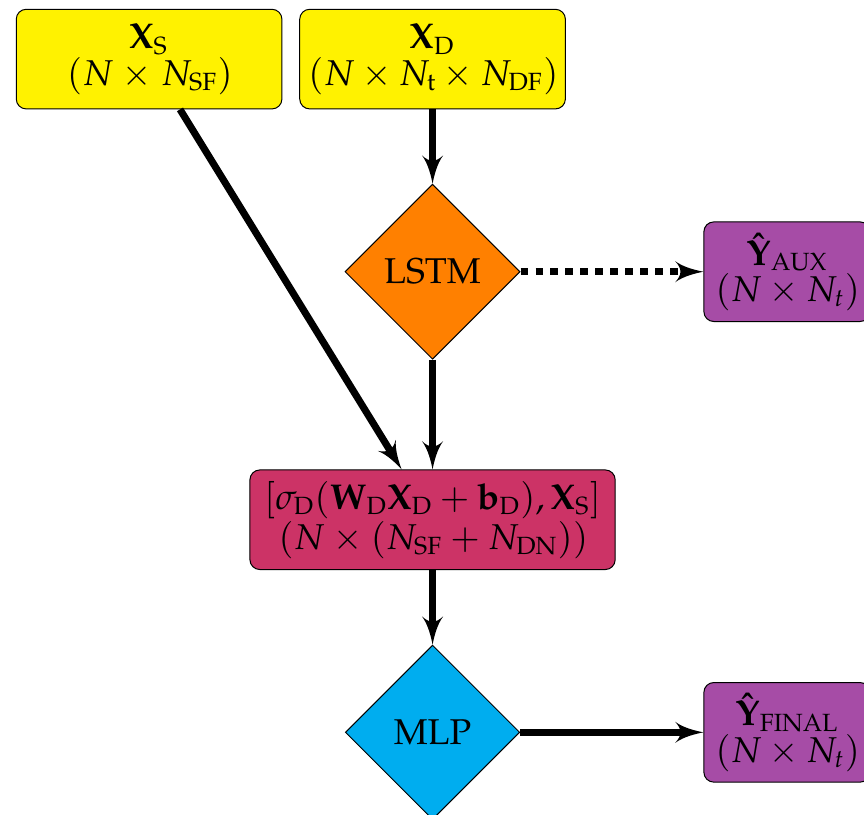
Figure 2. Hybrid architecture where X D is the three-dimensional array of dynamic (time series) inputs, X S is the two-dimensional array of static inputs, N is the number of samples, N t is the number of time steps, N DF is the number of dynamic features, N SF is the number of static features, and N DN is the number of nodes in the long short-term memory (LSTM)